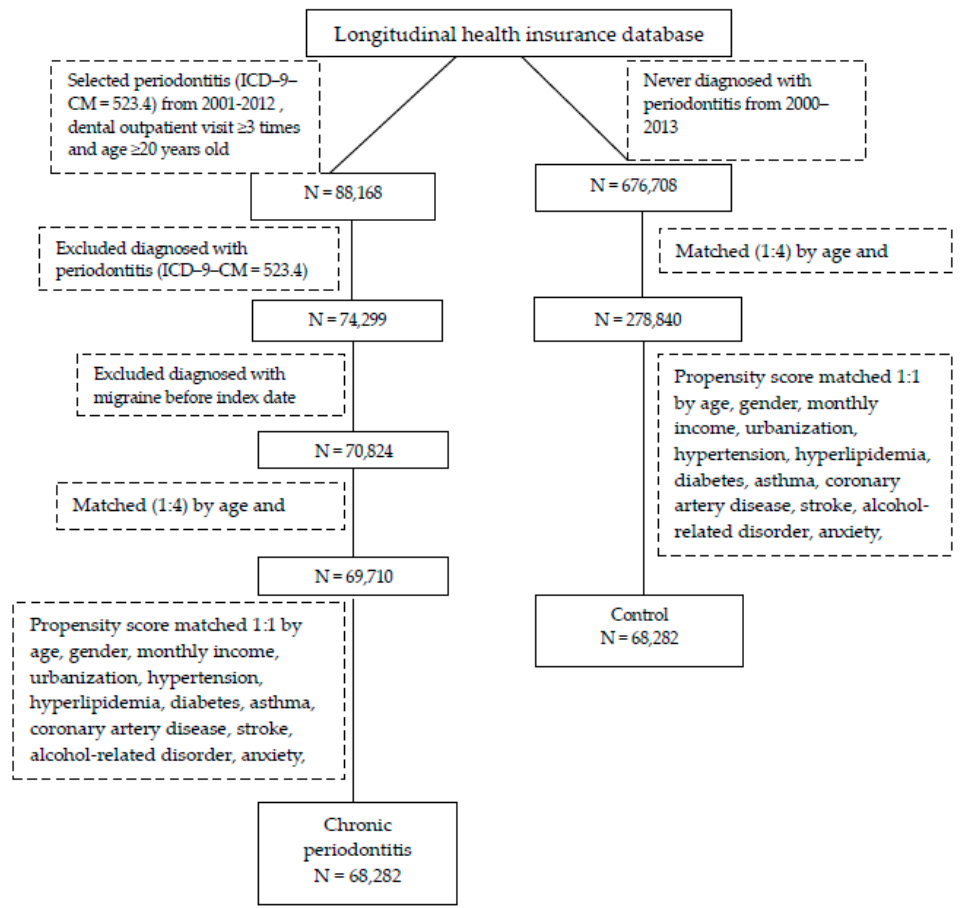
Figure 1. Flowchart illustrating the exclusion and inclusion criteria for this study. ICD-9-CM: International Classification of Disease, Revision 9, Clinical Modification.